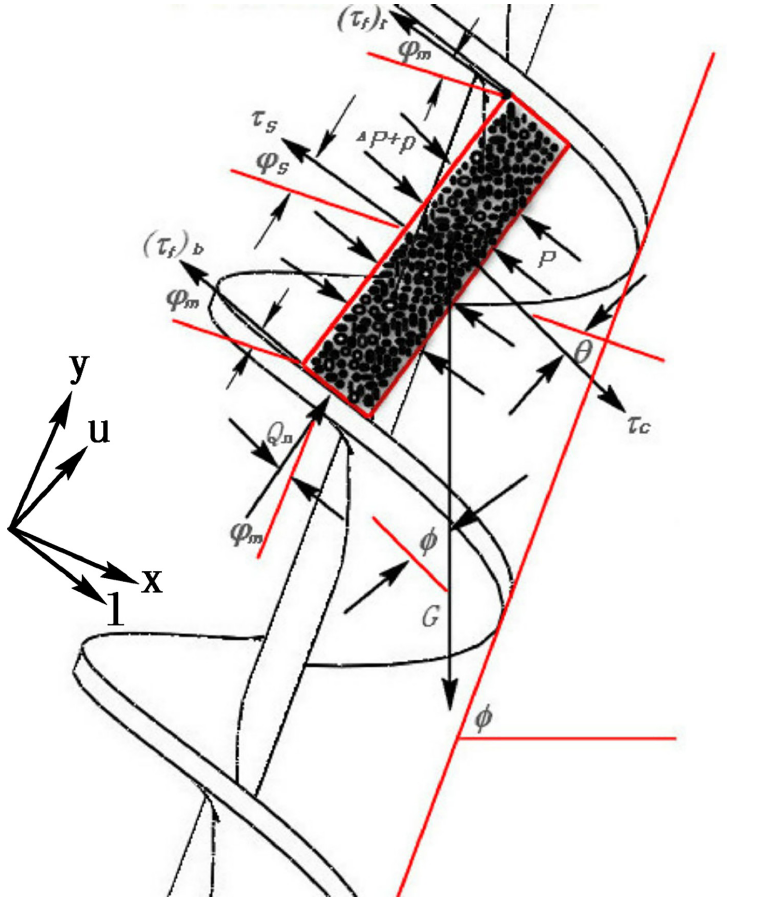
Fig 6. The forces acted on the soil